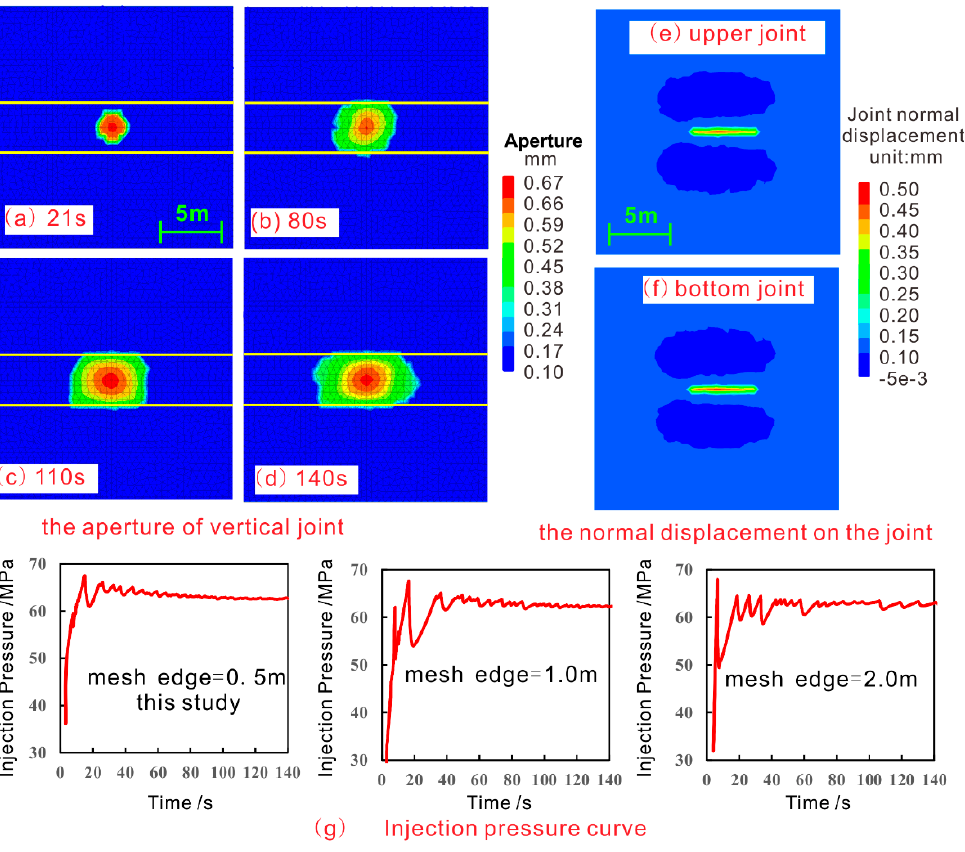
Figure 4. Geometric profiles of fluid-driven fractures at different times: ( a ) 21 s, ( b ) 80 s, ( c ) 110 s, and ( d ) 140 s; and normal displacement on ( e ) the upper horizontal joint and ( f ) the bottom horizontal joint.; ( g ) the curves of injection pressure.